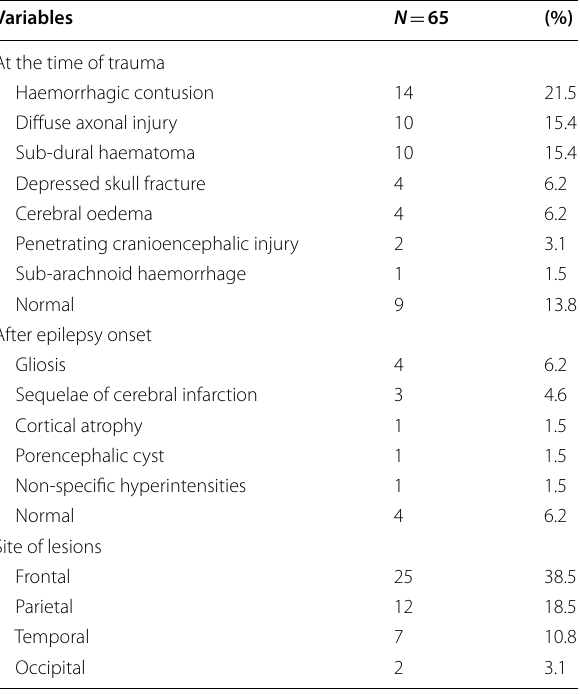
Table 2 Features of the traumatic brain injury leading to